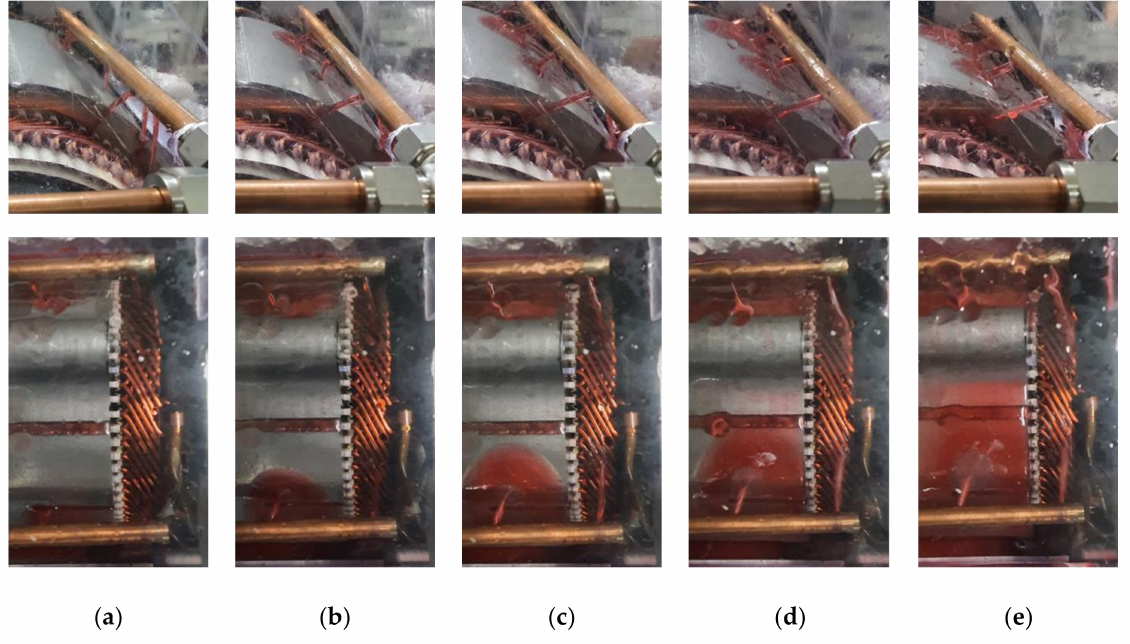
Figure 9. Oil flow according to the mass flow rate at 60 ◦ C, 600 rpm: ( a ) 0.028; ( b ) 0.056; ( c ) 0.084; ( d ) 0.112 kg; and ( e ) 0.140